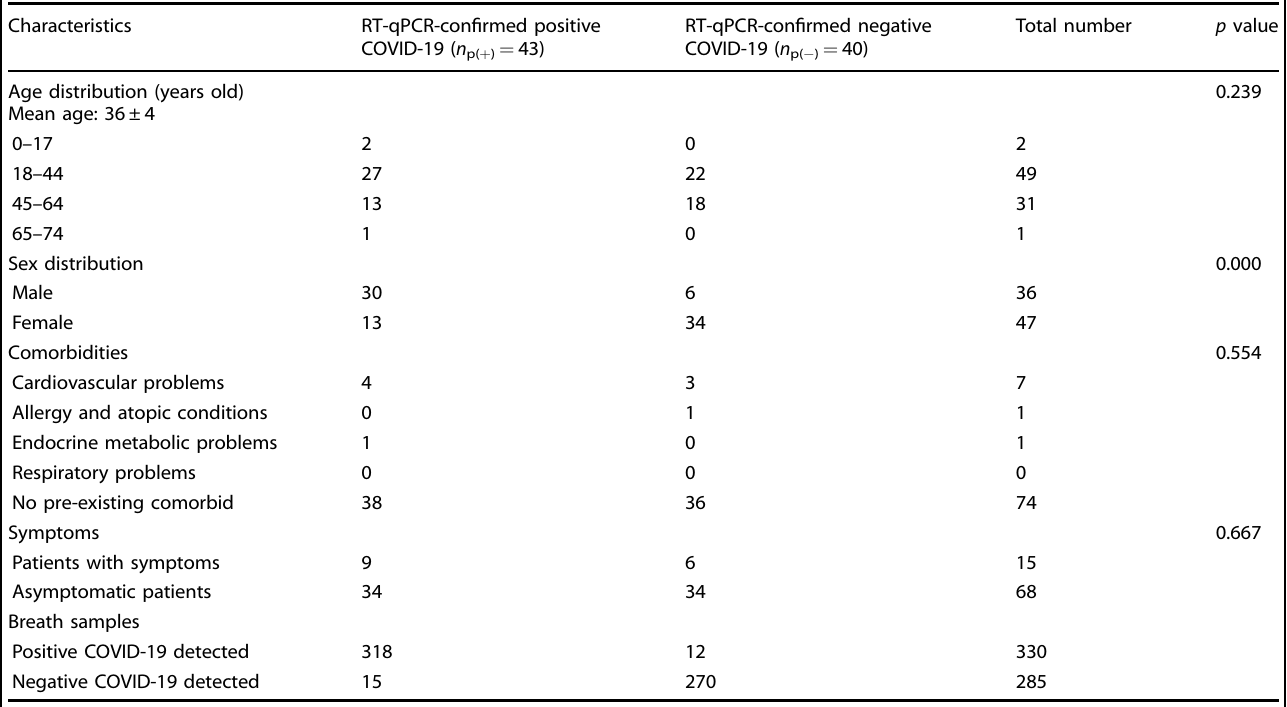
All the positive and negative COVID-19 patients have been tested and con fi rmed using reverse transcription-quantitative polymerase chain reaction (RT-qPCR). P value is measured using a non-parametric statistical test (i.e., Kruskal – Wallis test), where p value <005 is considered to be statistically signi fi cant.